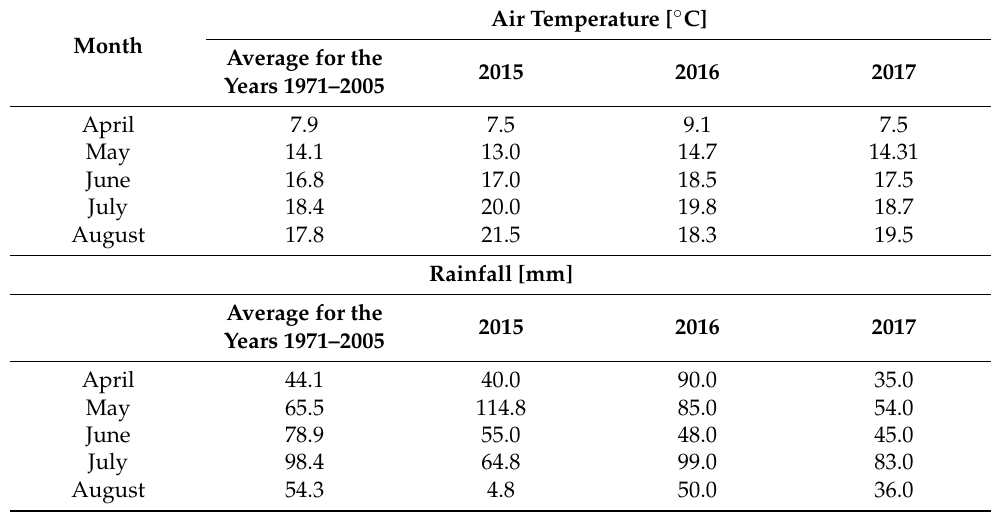
Table 8. Weather conditions in Zamo´s´c, (Lublin region) during 2015–2017 oat growing seasons. Air Temperature [ ◦ C] Month Average for